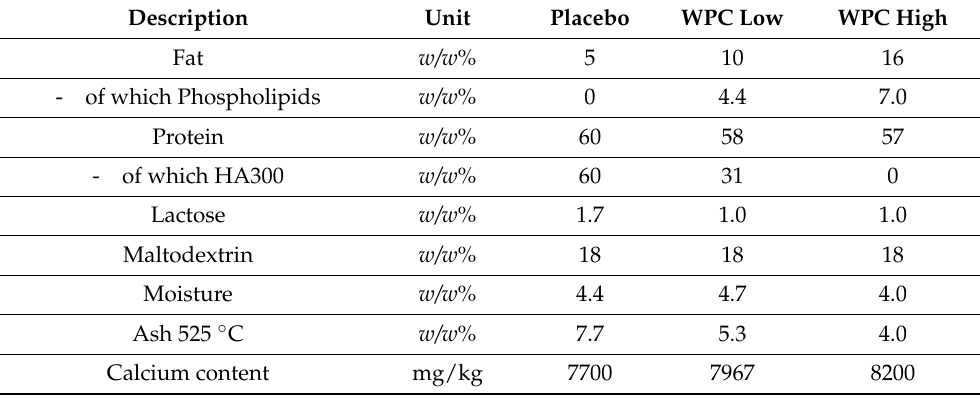
Table 1. Nutritional composition of placebo, WPC low and WPC high investigational products indicated as percentage by weight of the powder, except for calcium, which is expressed as mg/kg. Description